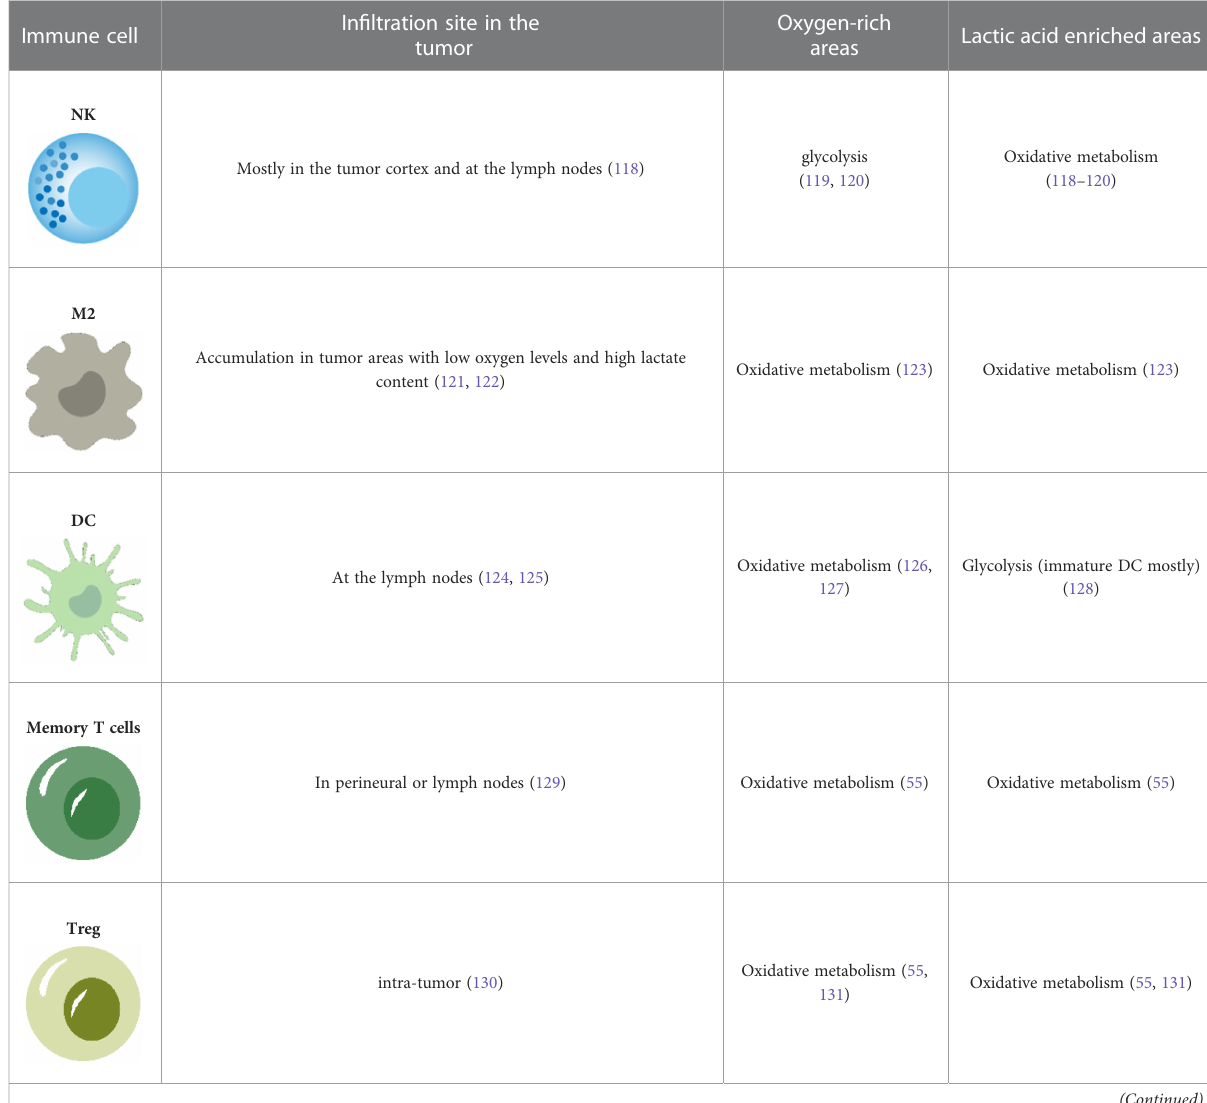
TABLE 1 Metabolism of immune cells in melanoma.